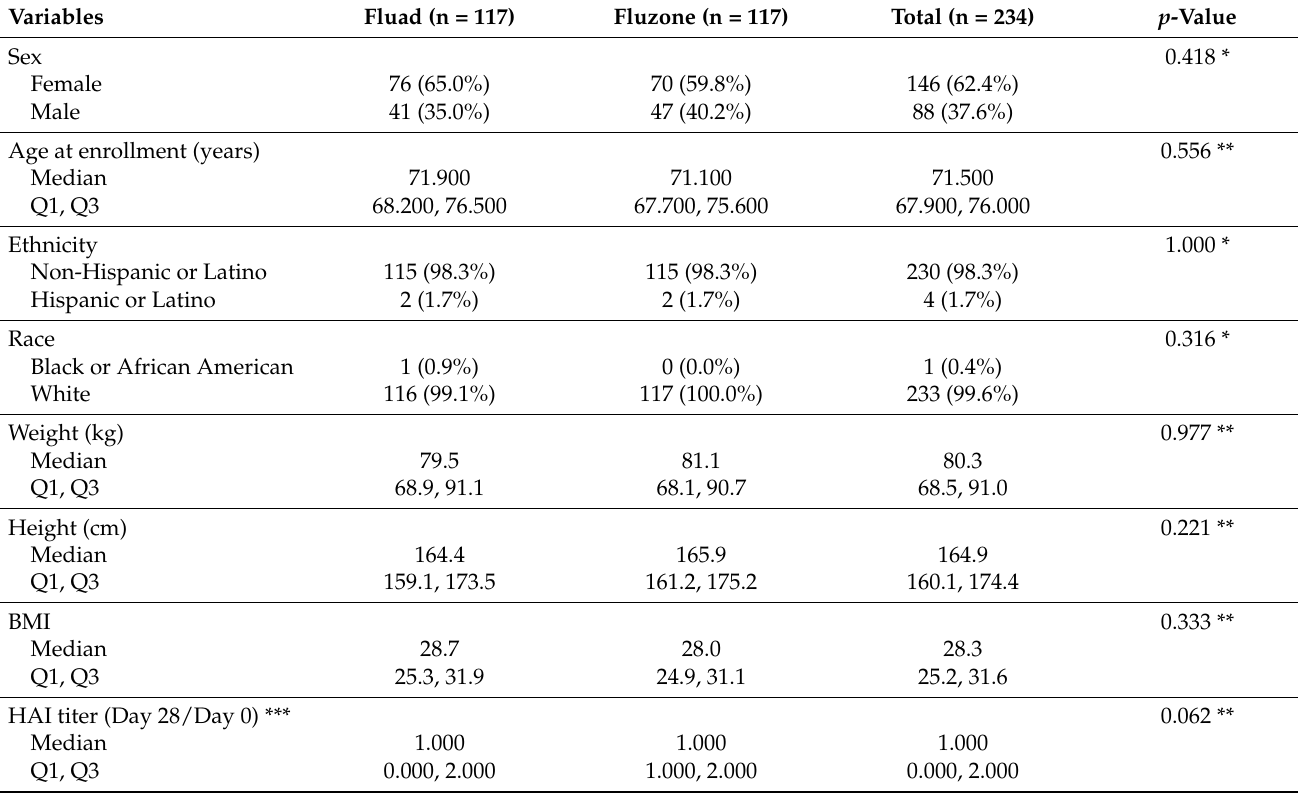
Table 1. Demographic and clinical variables of the study